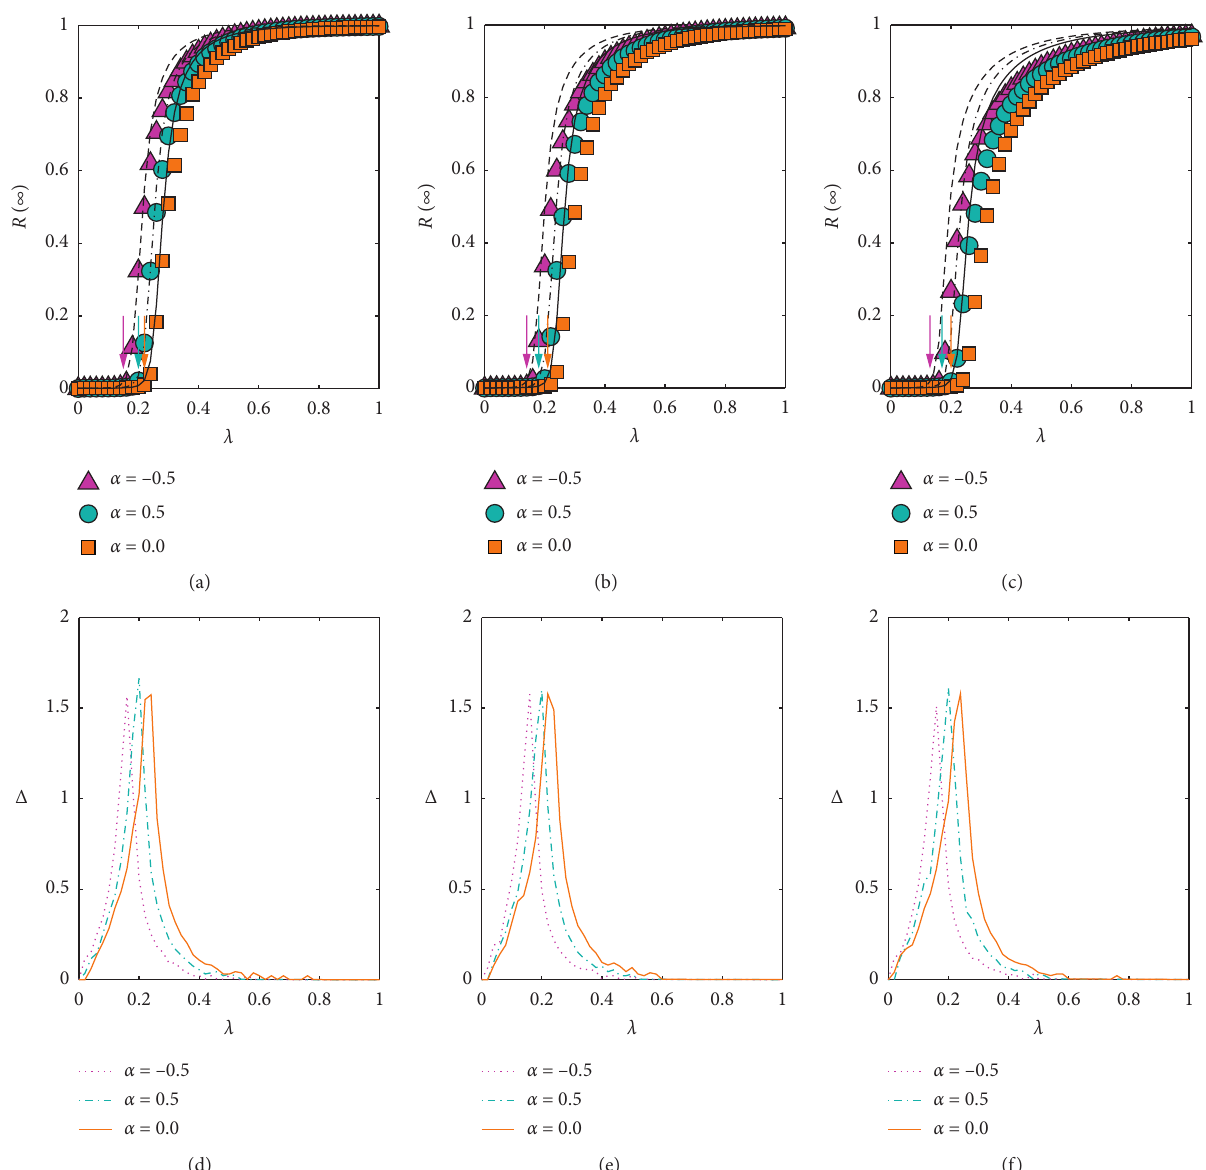
Figure 1: The variation of the outbreak size R ( ∞ ) with the transmission probability λ with different preference selection parameters β . (a) ( β � − 1), (b) ( β � 0), and (c) ( β � 1). The symbols and lines are the simulated and theoretical values of R ( ∞ ) in (a)–(c), respectively, where α � − 0 . 5 (pink triangles), α � 0 . 0 (orange squares), and α � 0 . 5 (blue-green circles). The arrows are theoretical outbreak threshold. The simulated outbreak threshold Δ as a function of λ with β � − 1 (d), β � 0(e), and β � 1 (f) for the corresponding values of α in (a)–(c), respectively. Another parameter is f � 0 .